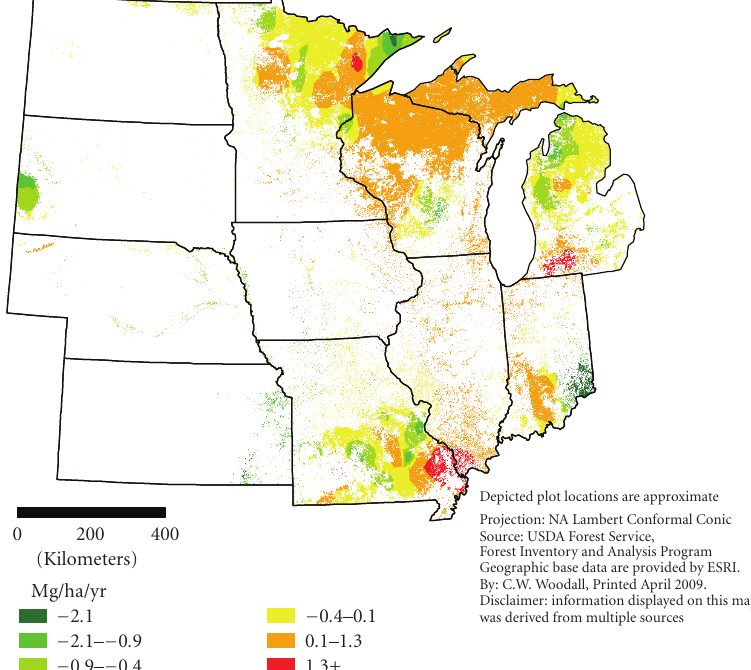
Figure 3: Interpolated surface (inverse distance weighting) of annual down dead wood carbon flux across the north central United States, 2002 to